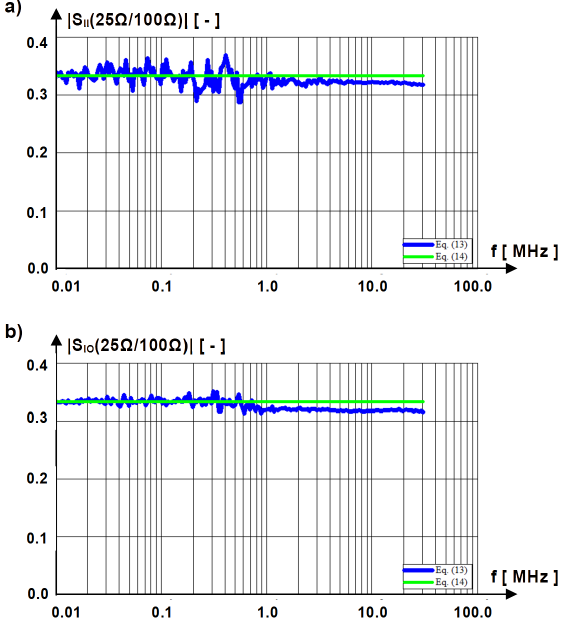
Figure 7. The parameters of the modal conversion of the common mode at the input to the differential mode at the output: reflection ( a ) and transmission ( b